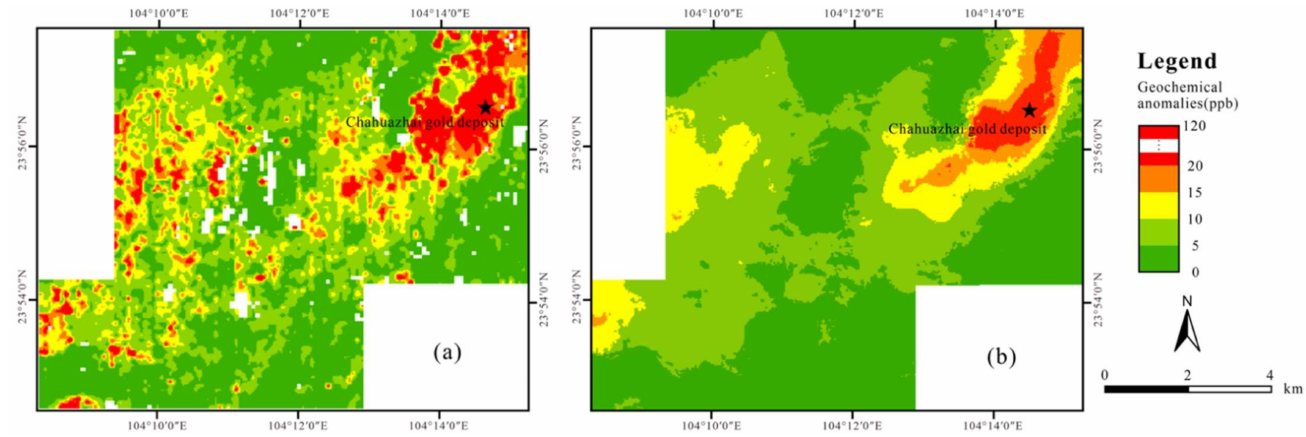
Figure 16. ( a ) Geochemical exploration sampling results; ( b ) GWR prediction